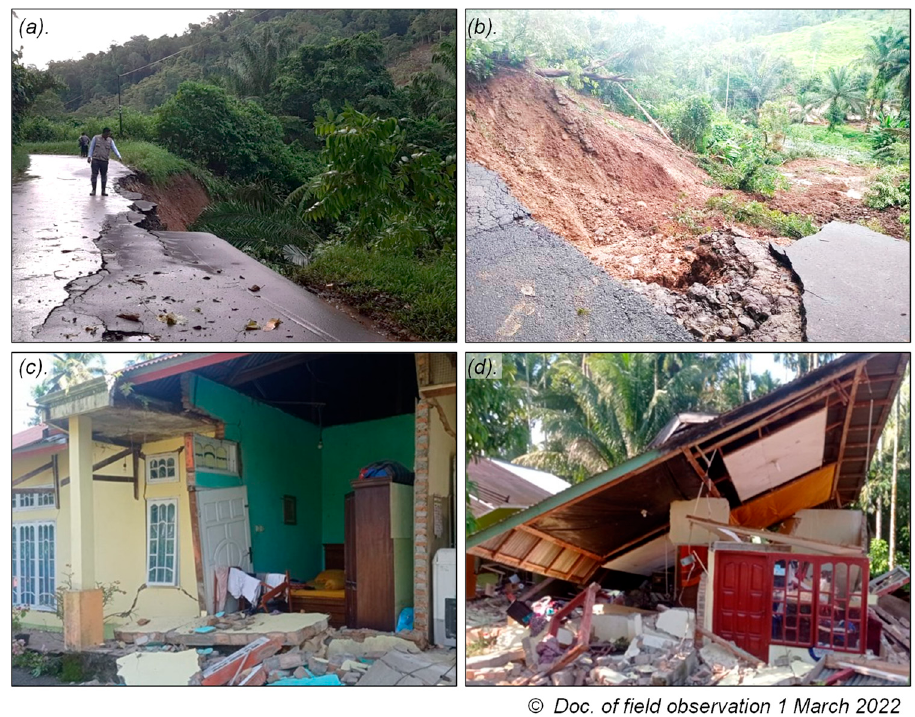
Figure 2. Damage of the Pasaman earthquake: ( a ) landslide, ( b ) road damage, and ( c , d ) building structural damage.